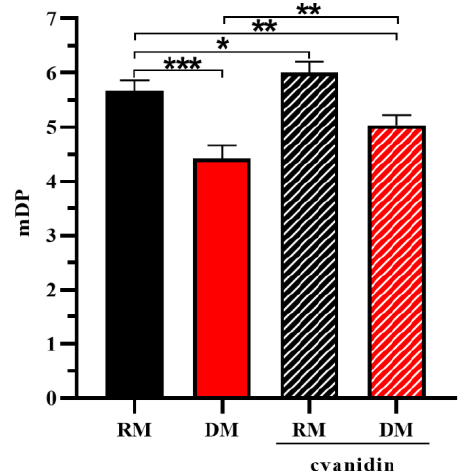
Figure 7. Comparison of the mDP analyzed with the recognized method (RM) and the direct method (DM), considering cyanidin formation or not. * p < 0.05; ** p < 0.01; *** p < 0.001. Overall, proanthocyanidin purification and anthocyanidin formation did not influence the subunit composition of proanthocyanidins, but markedly altered their mDP. The method coupling HILIC and RPHPLC was able to directly analyze proanthocyanidins in grape seed extract for more accurate results of mDP than the recognized method.